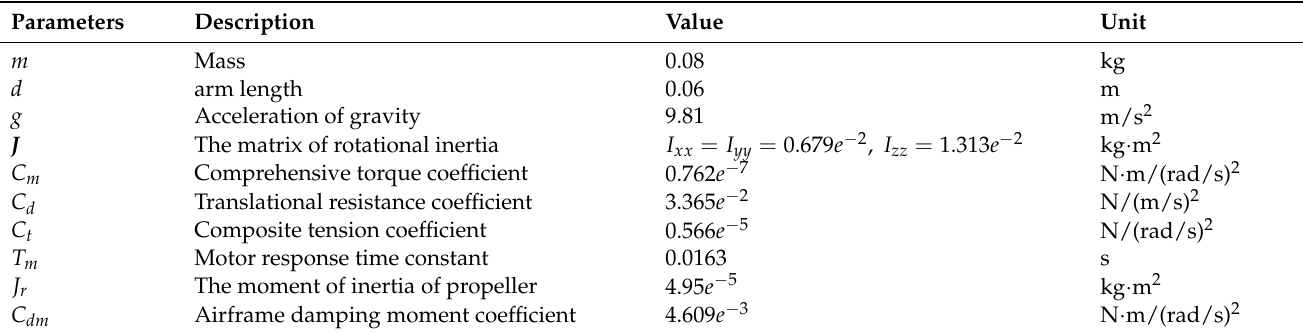
Table 1. Parameters of the quadrotor UAV.